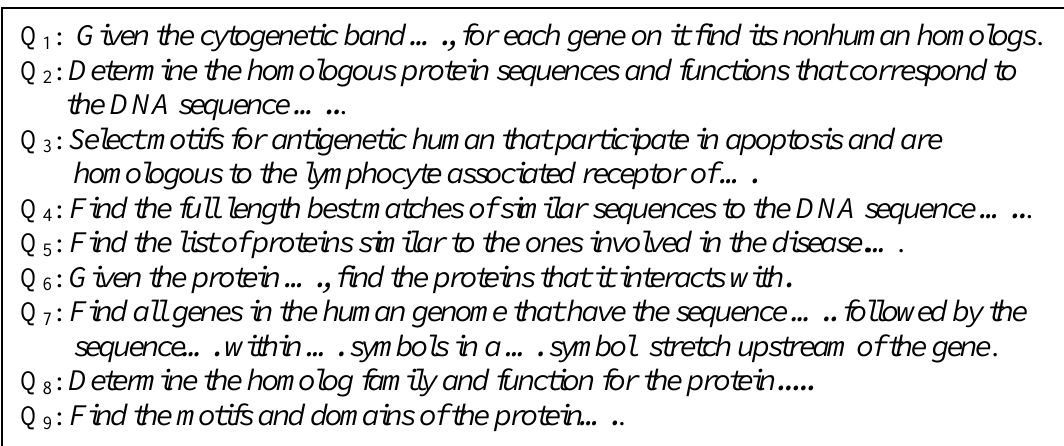
Fig. 1: A sample of nine Query